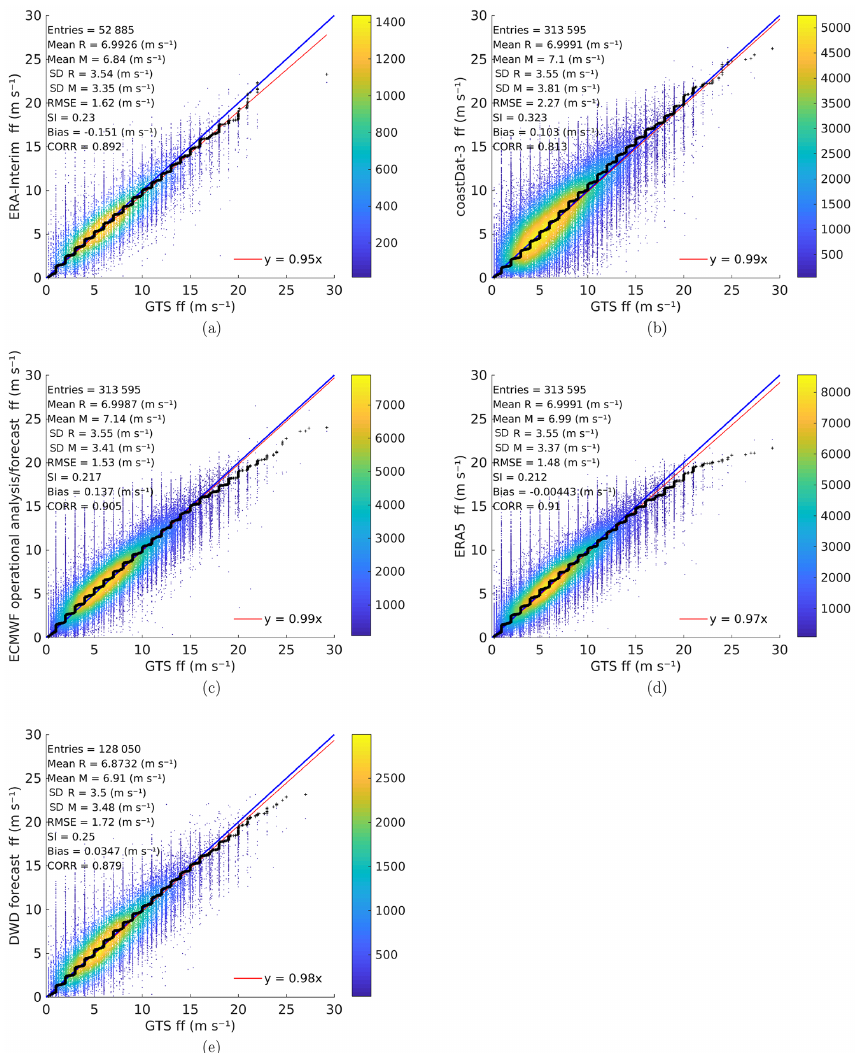
Figure 3. Q–Q scatter plot for measured (GTS wave buoys) wind speeds as reference (R) and modelled wind speeds (M) from (a) ERA- Interim, (b) coastDat-3, (c) ECMWF operational analysis/forecast, (d) ERA5 and (e) DWD forecast from June to November 2016: Q–Q plot (black crosses), 45 ◦ reference line (blue line) and least-squares best-fit line (red